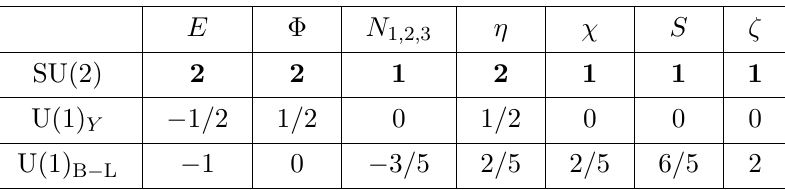
Table 2 . Charge assignments of the particles in the gauged U(1) B (cid:0) L extension of the (cid:23) SIMP